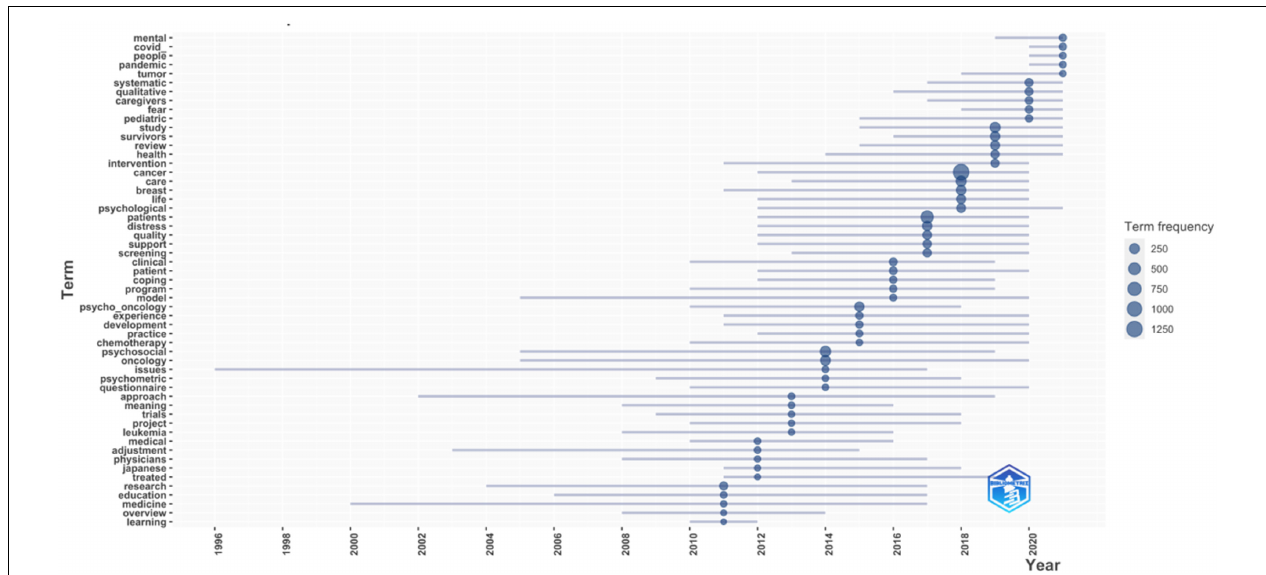
FIGURE 10 | Trend topics in psycho-oncology in the last 10 years